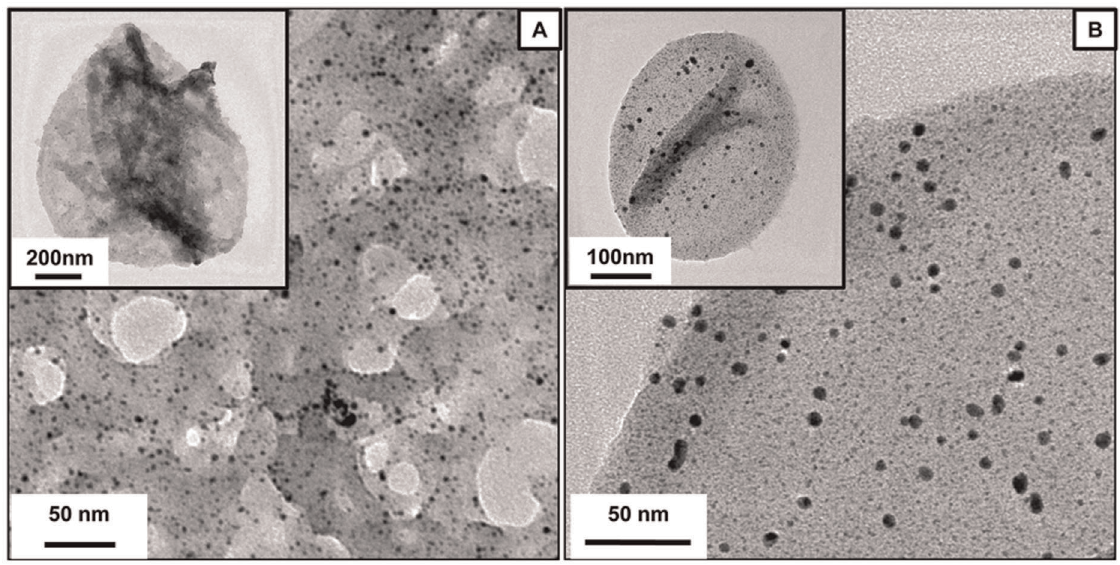
Figure 6. Nanoparticles in different sizes of capsules. TEM image of Au nanoparticles loaded (a) 1 m m sized PSS/PAH capsules and (b) cross- linked PAH nanocapsules ( , 400 nm).